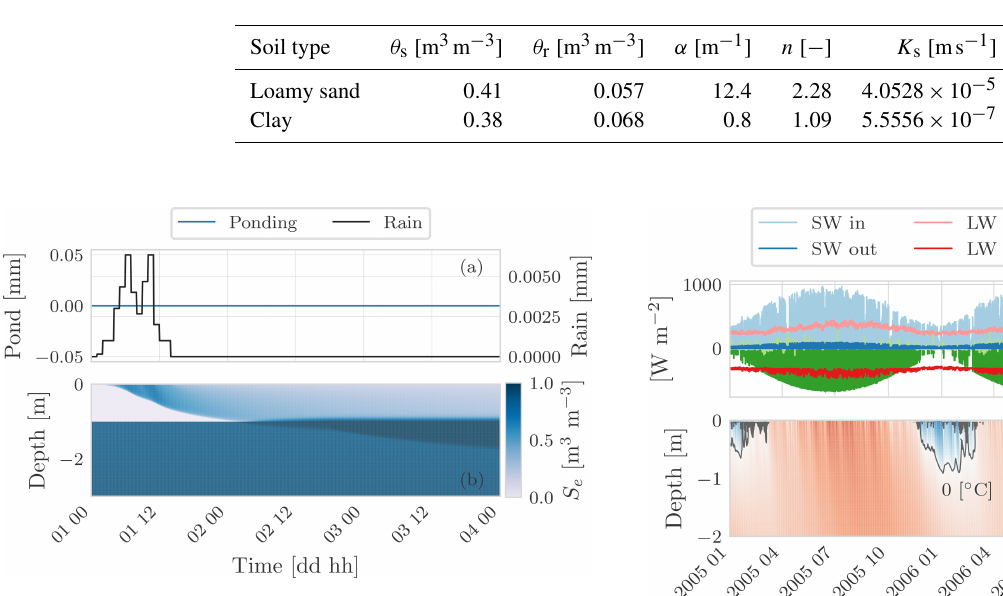
Table C4. Hydraulic properties of the loamy sand layer and clay layer in Bonan (2019) for the numerical experiment on Dunnian runoff due to rainfall.